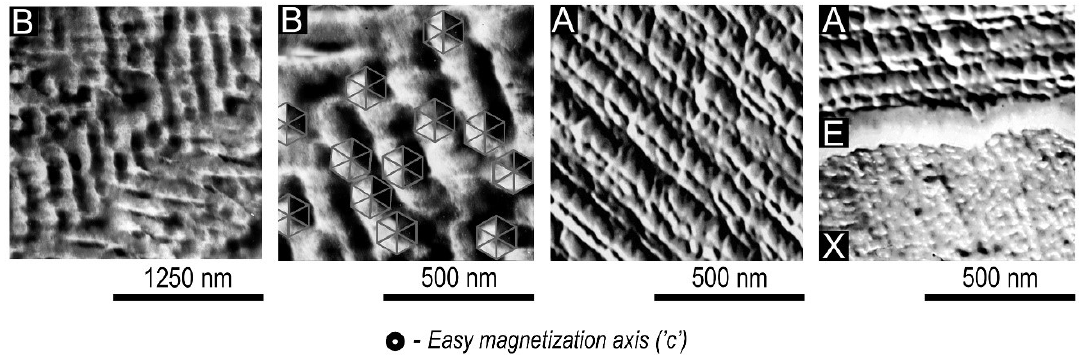
Figure 5. Typical morphology of structural components B and A and the E and X phases within component A (SE, SEM). The structure of component A is presented by regular rows of quasi-spherical pre- cipitates less than 50 nm in size.